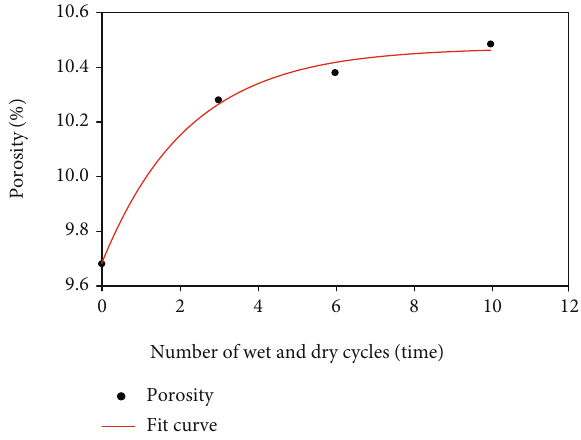
Figure 4: Fitting curve of relationship between porosity and number of dry and wet